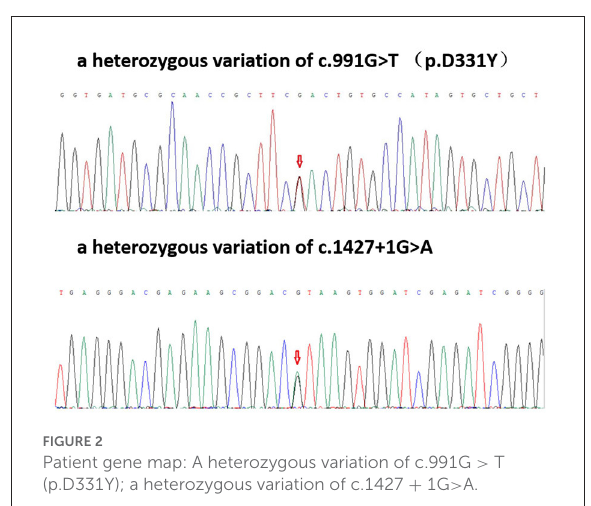
FIGURE2 Patient gene map: A heterozygous variation of c.991G > T (p.D331Y); a heterozygous variation of c.1427 + 1G > A.